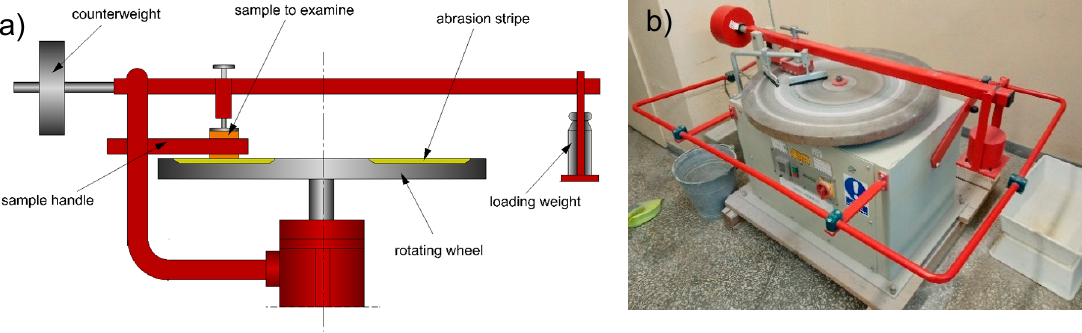
Figure 5. The scheme (a) and view (b) of the Boehme test device.